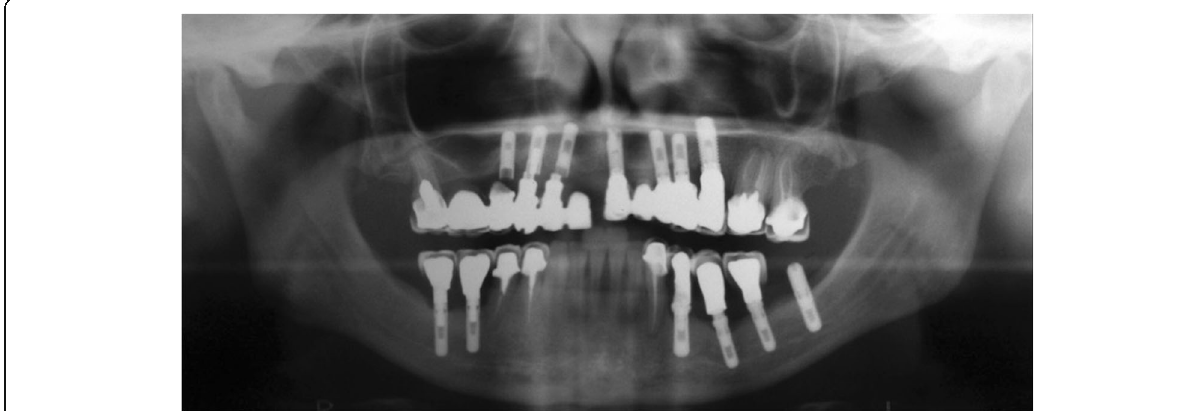
Fig. 1 Radiograph of the fractured implants united to a tooth after 45 months in